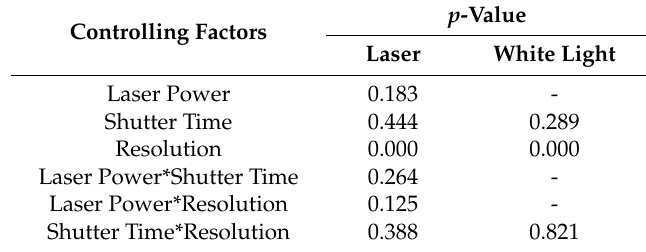
Controlling Factors